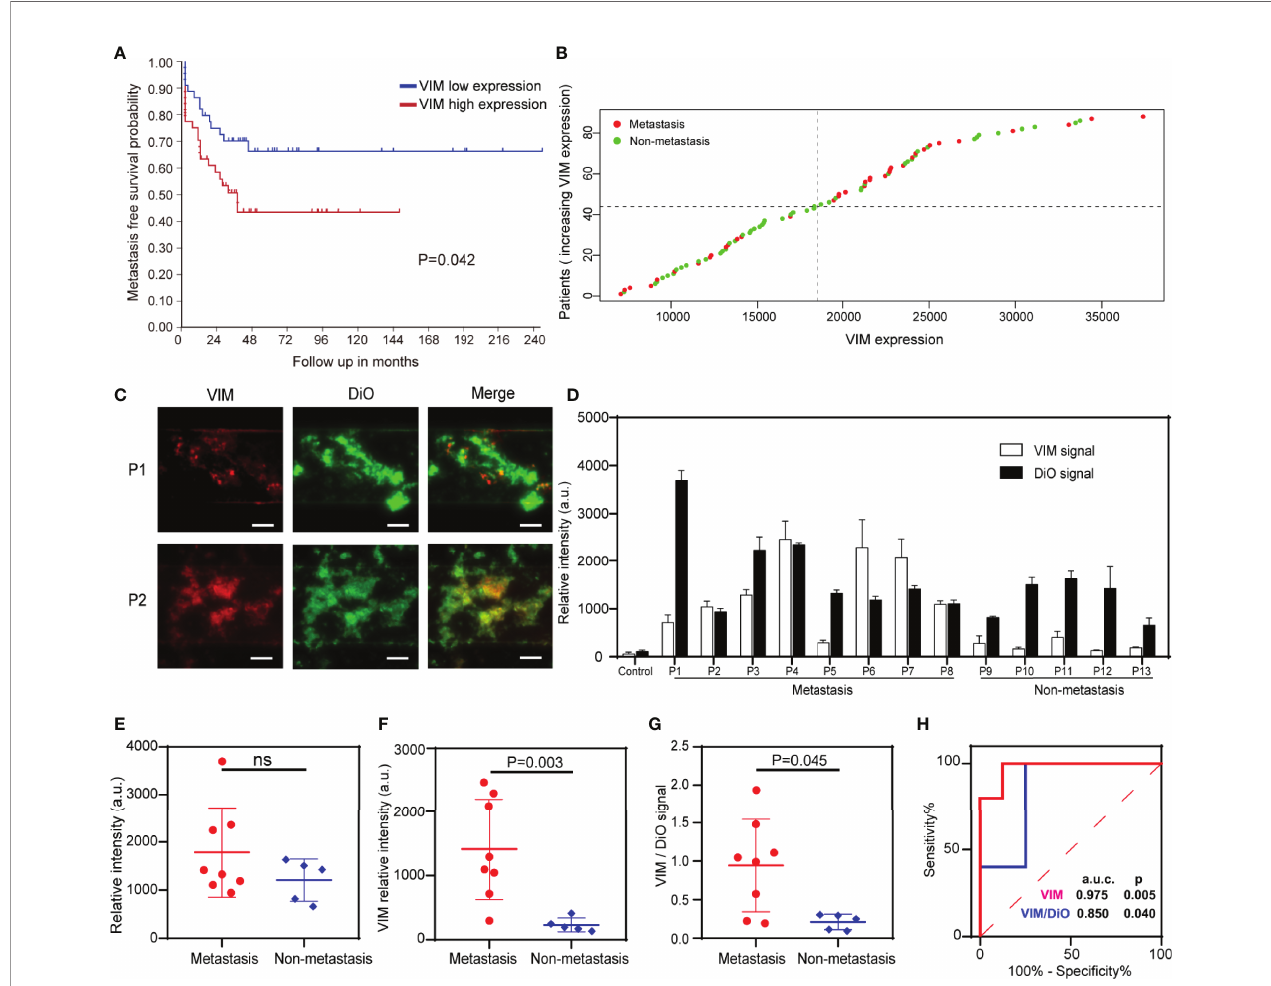
FIGURE 5 | Detection of total EVs and VIM-positive EVs for the surveillance of OS metastasis. (A) Metastasis-free survival probability curve of OS patients with VIM high expression and low expression. (B) Scatter diagram of VIM expression of OS patients with and without metastasis. (C) Exemplary images of immuno fl uorescence of total EVs and VIM-positive EVs in 2 plasma samples. Scale bar: 100 m m. (D) Quanti fi cation of the EV membrane VIM directly from the plasma of the metastatic OS patients ( n = 8) and non-metastatic patients ( n = 5). Error bars indicate s.d. ( n = 3). (E) Fluorescence quanti fi cation of the total EVs in OS patients with and without metastasis. ns, non-signi fi cant. (F, G) The VIM fl uorescence signal and the VIM/DiO fl uorescence ratio of the plasma EVs derived from OS patients with and without pulmonary metastasis. The statistical difference of the two groups was compared using the Mann-Whitney U test. (H) ROC analysis of VIM absolute signal and VIM/DiO ratio between the metastasis group and the non-metastasis